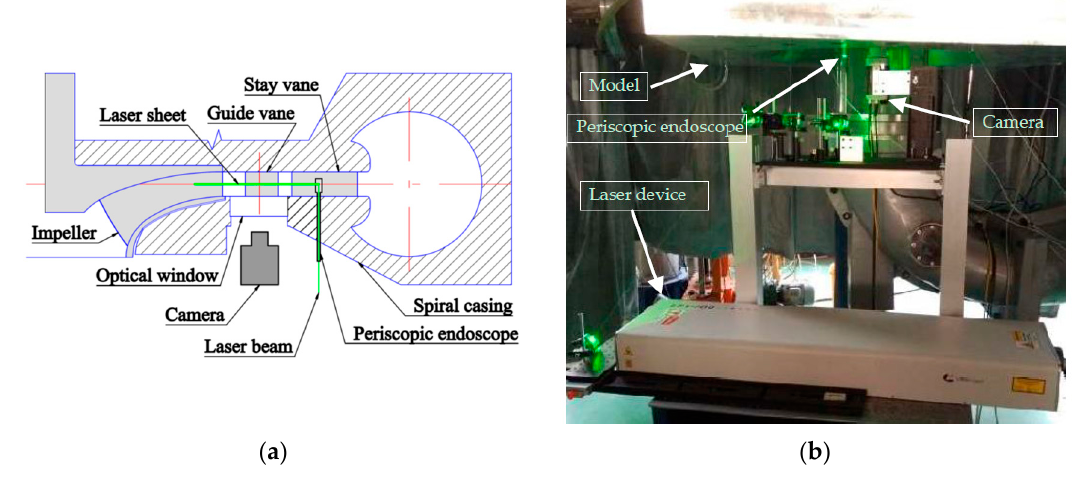
Figure 2. Setup and the measurement plane. ( a ) Sketch map; ( b ) Equipment.